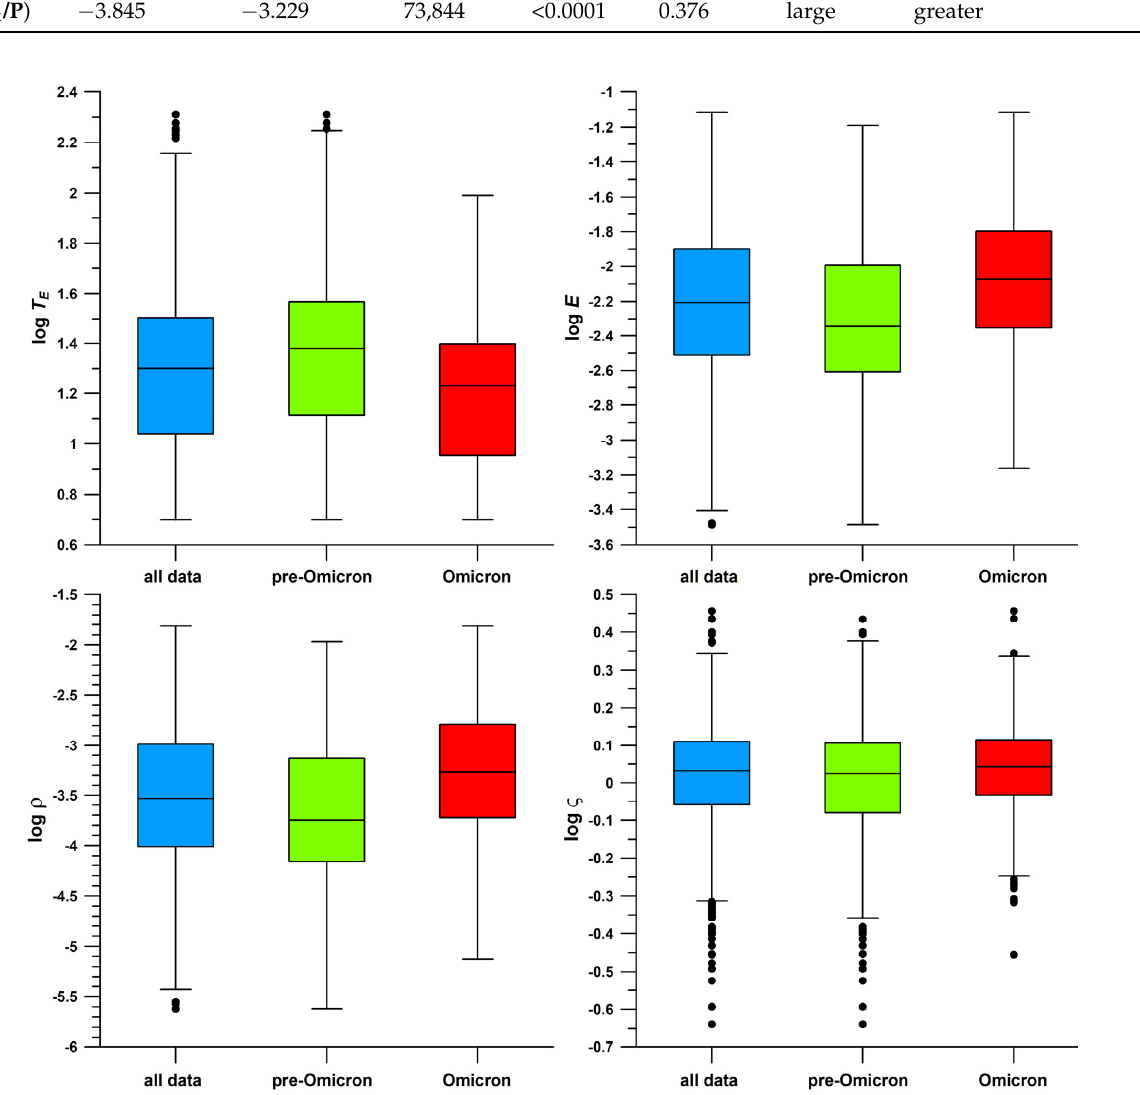
Figure 8. Box and Whisker plots of effectiveness parameters such as duration of the effective phase T E , effectiveness E , ρ and log ς of 1000 COVID-19 waves, thereof 615 pre-Omicron and 385 Omicron waves. Table 2. Comparison of medians of pre-Omicron ( n = 615) and Omicron ( n = 385) waves (wave ratio 8:5); U = U-statistic value of the Mann–Whitney test; p = probability value; r = effect size; T E = dura- tion of the effective phase; E = effectiveness (of wave management); ρ = E / T E and log ς = wave shape factor; v max = peak velocity; v max / P = peak velocity per population P .